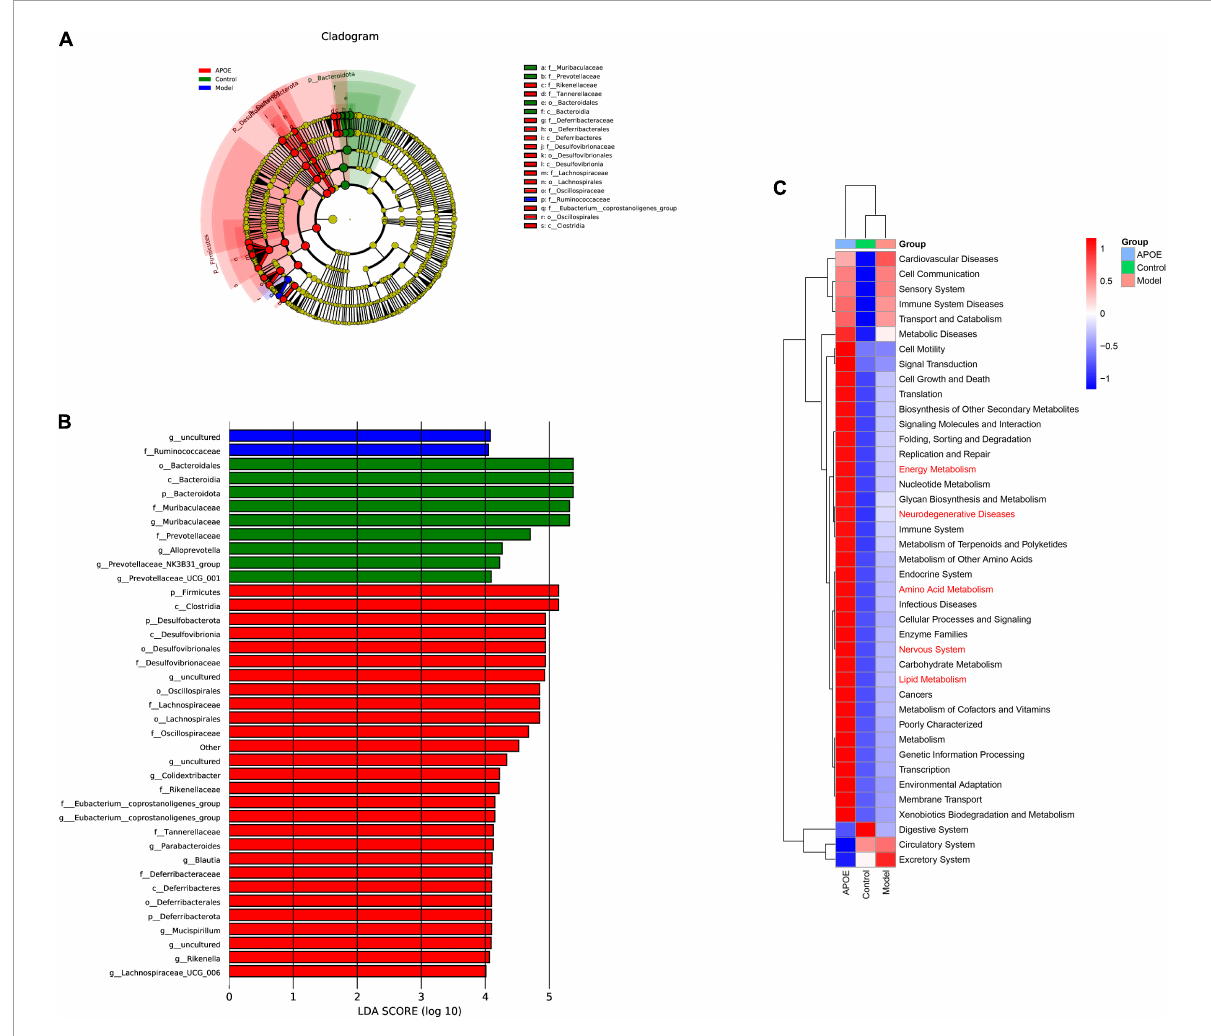
FIGURE5 LEfSe and PICRUSt2 analysis. (A) Cladogram of LEfSe analysis. (B) LDA of LEfSe analysis. (C) PICRUSt2